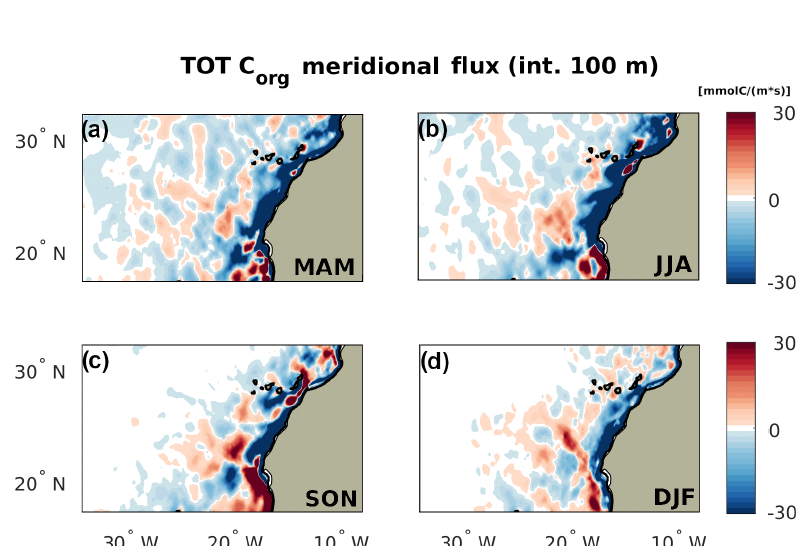
Figure B2. Seasonality of the total meridional transport of C org by season, with positive meaning northward. The flux is integrated throughout the first 100m